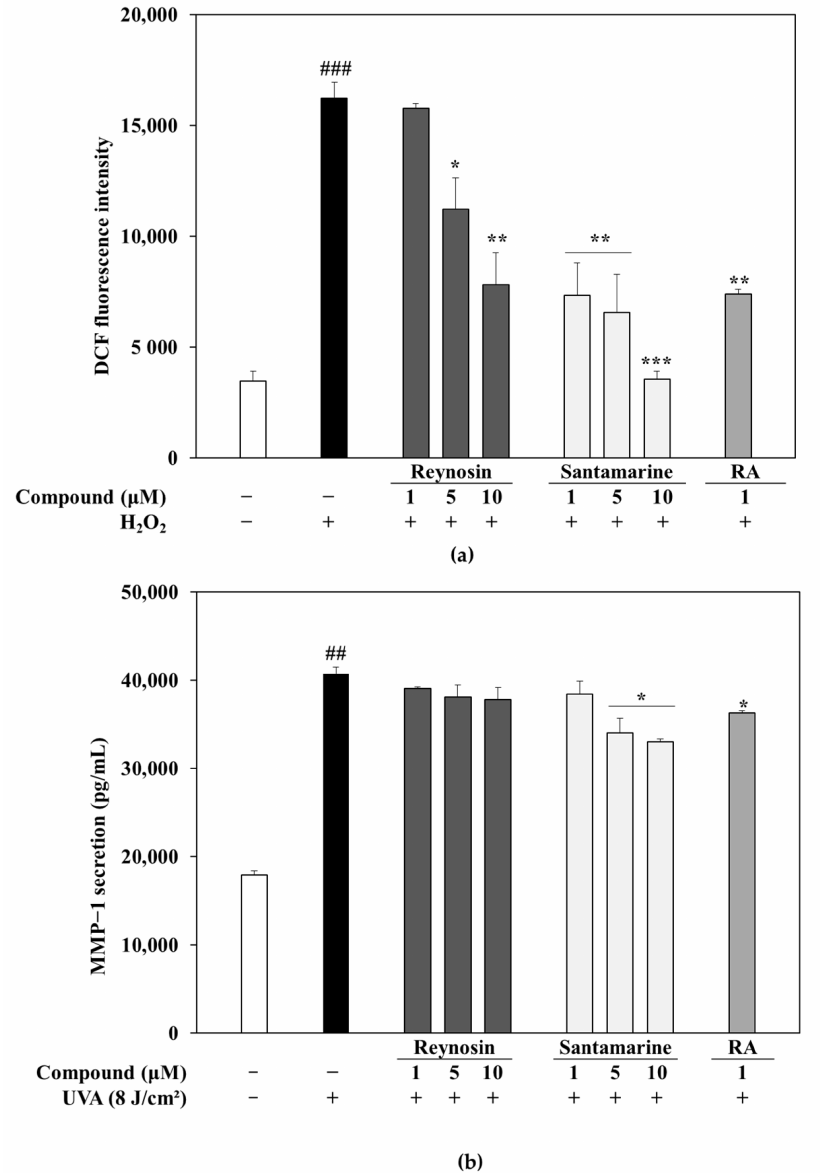
Figure 3. Effect of reynosin and santamarine on the generation of intracellular reactive oxygen species (ROS) and MMP-1 secretion in H 2 O 2 -treated and UVA-irradiated (8 J/cm 2 ) HDFs, respectively. ( a ) ROS scavenging effects of reynosin and santamarine were analyzed after 24 h treatment by the DCFH-DA assay and given as the fluorescence intensity showing DCF generation via intracellular ROS. ( b ) MMP-1 secretion of the UVA-irradiated HDFs was measured by an ELISA kit following 24 h treatment. Values are means ± SD ( n = 3). * p < 0.05, ** p < 0.01 and *** p < 0.001 vs. H 2 O 2 or UVA only control. ## p < 0.01 and ### p < 0.001 vs. non-treated control. Retinoic acid (RA) was used as positive